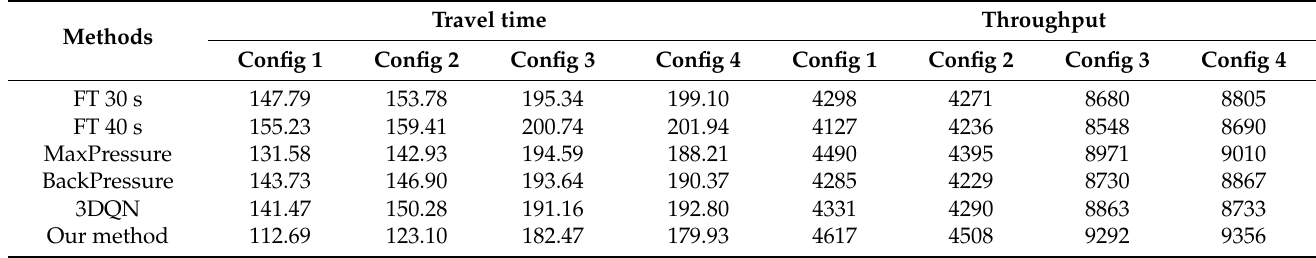
Table 4. Performance comparison of different methods on the RN 3 × 3 network.